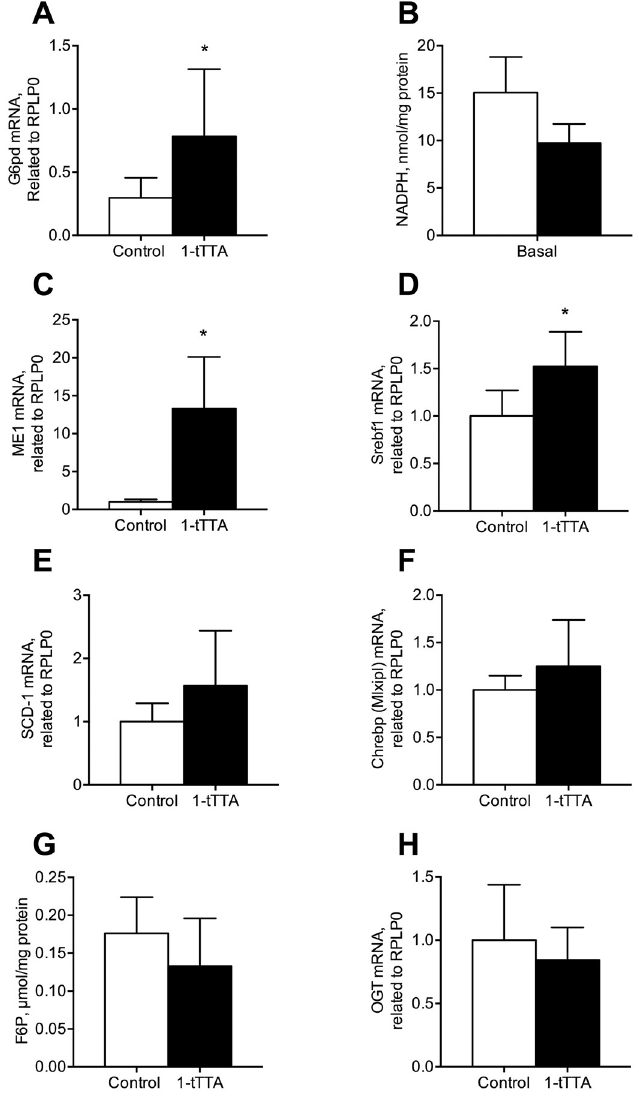
Fig 7. Hepatic NADPH level and expression of genes involved in the pentose phosphate pathway and the hexosamine pathway after 3 weeks treatment with vehicle (control) or 1-triple TTA (1-tTTA) in rats. ( a ) glucose- 6-phosphate dehydrogenase ( G6pd ) mRNA level, ( b ) NADPH level, ( c ) malic enzyme ( Me ) mRNA level, ( d ) sterol regulatory element-binding protein 1 ( Srebp1 ) mRNA level, ( e ) stearoyl-CoA desaturase ( Scd-1 ) mRNA level, ( f ) ChREBP ( Mlxipl ) mRNA level, ( g ) fructose-6-phosphate (F6P) level, ( h ) o-linked N-acetylglucosamine transferase ( Ogt ) mRNA level. Gene expression levels were normalized to the house keeping gene RPLP0 and relative values are given. All values shown are means with standard deviation (n = 6–8). Statistically significant differences between means were determined using Student’s t-test, � p < 0.05 vs. control.